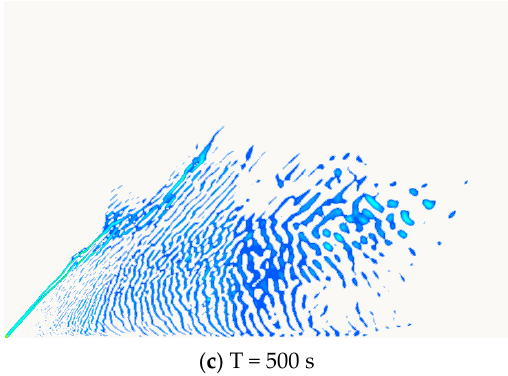
Figure 6. Oil diffusion trajectories for open waters.